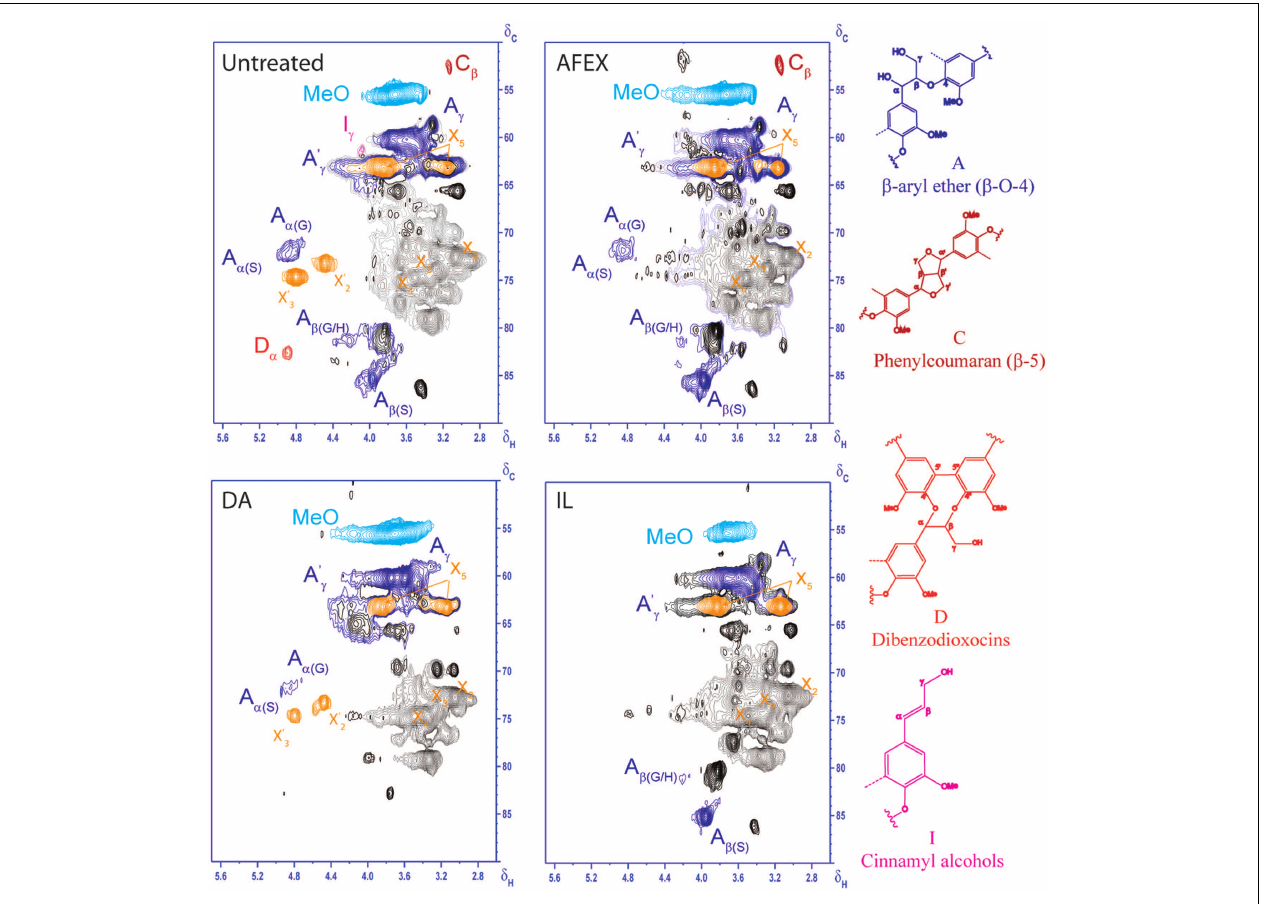
FIGURE 5 |Aliphatic region of HSQC NMR spectra of untreated and pretreated corn stover samples .